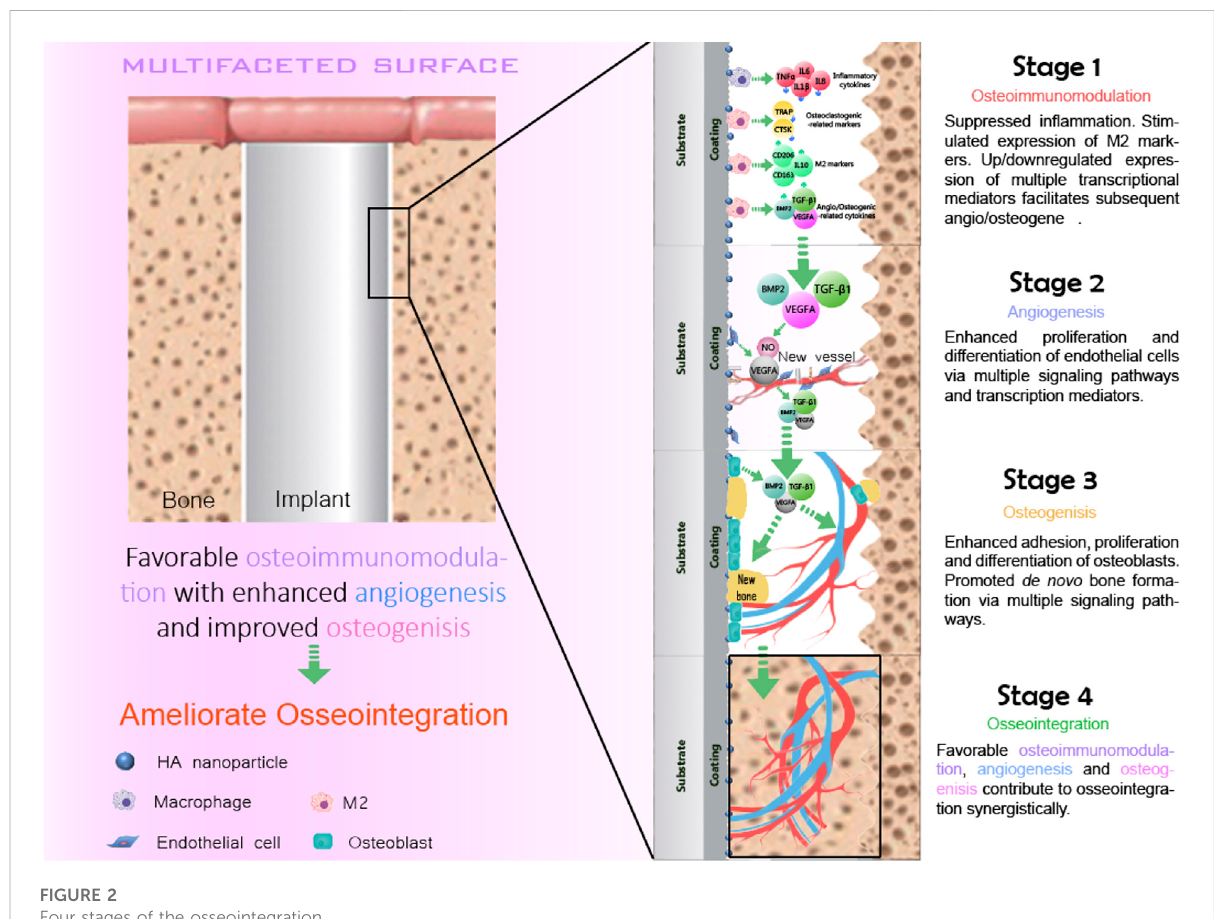
FIGURE 2 Four stages of the